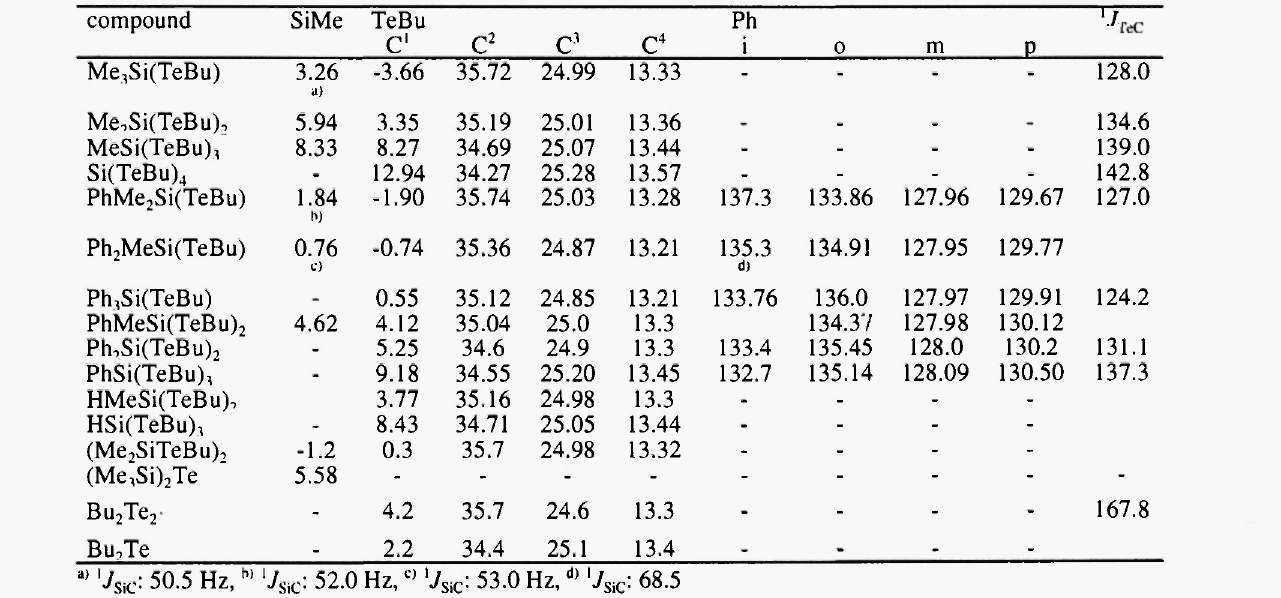
TeC (in Hz) of tellurobutyl-substituted silanes and related by-products